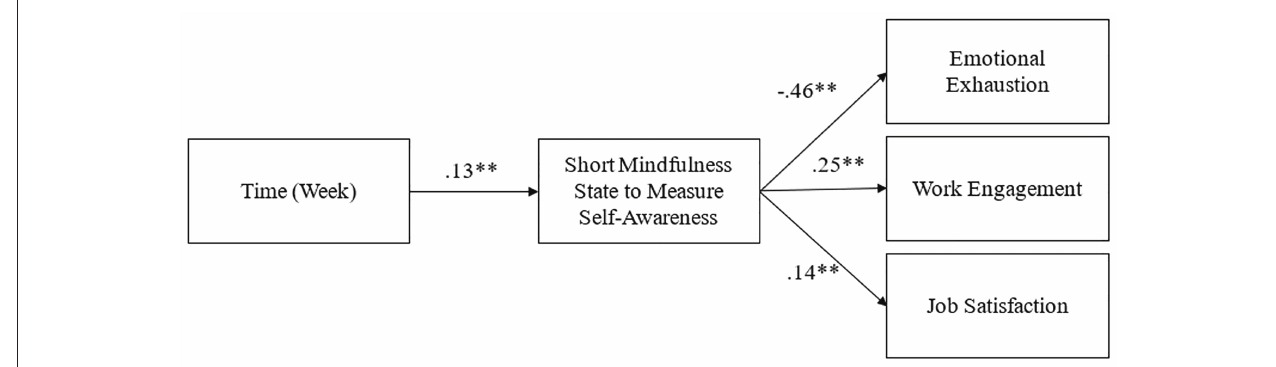
FIGURE 3 | Results of hypothesized model with path analyses. ** p <